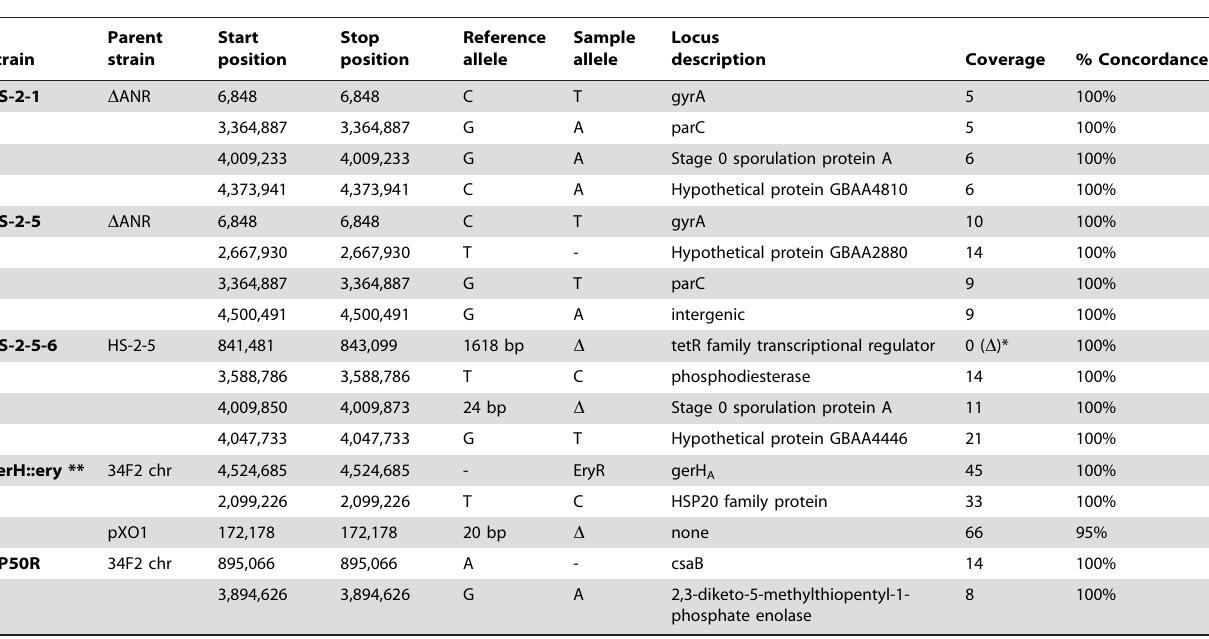
Table 2. Location of true positive variants in the genomes of mutant B. anthracis compared to the reference genome.